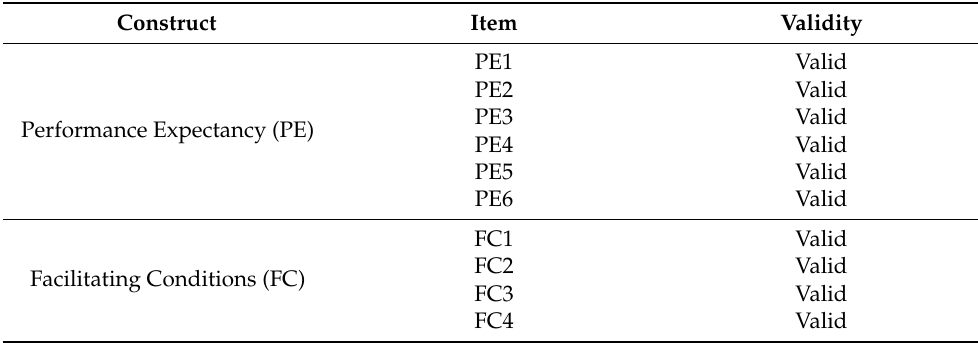
Table 5. Validity test results for the questionnaire.